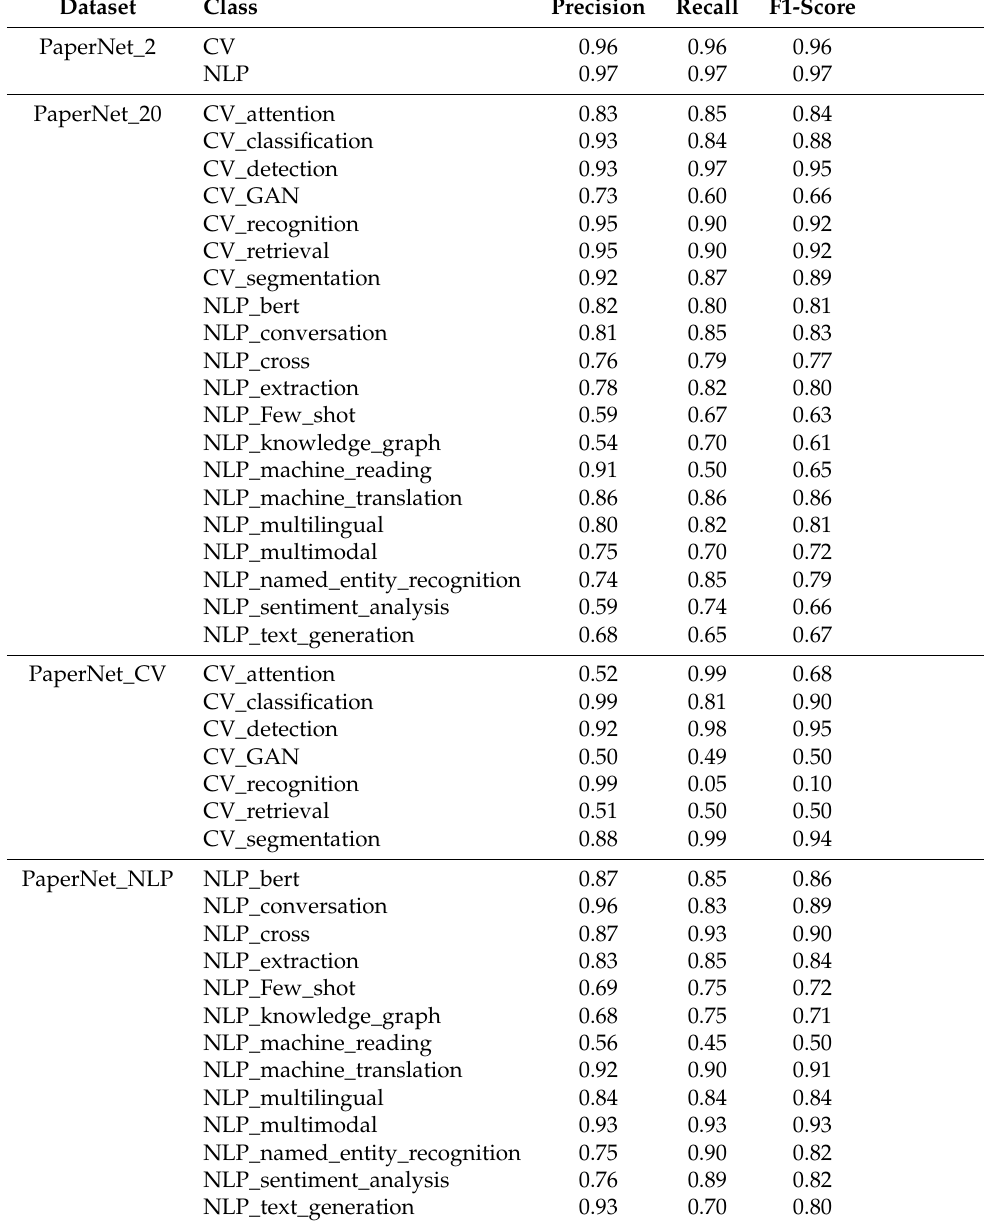
Table A2. Detailed results of the Adaboost